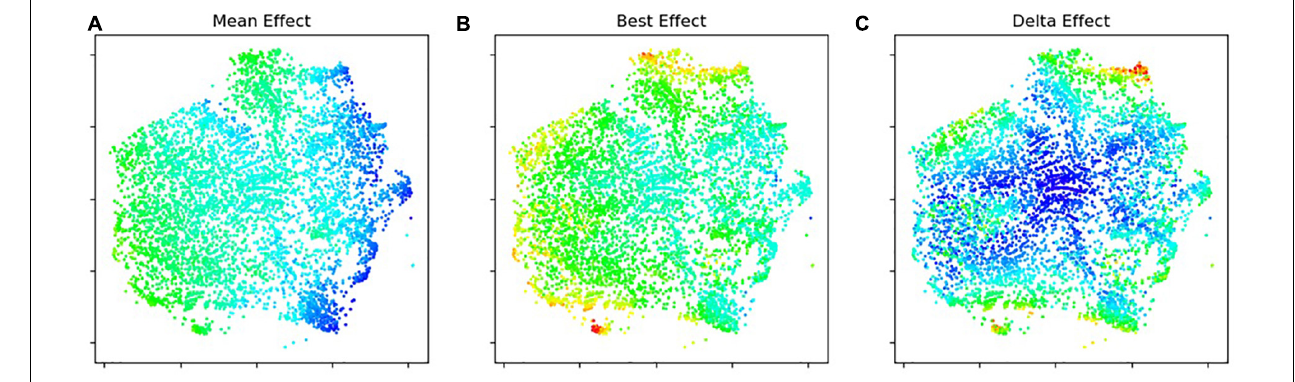
FIGURE 3 | Clustering diagrams made with T-SNE using potential effects on a simulated population. Coldest colors represent lowest values: mean message effect (A) ; best message effect (B) ; delta between best message effect and mean message effect (C) .